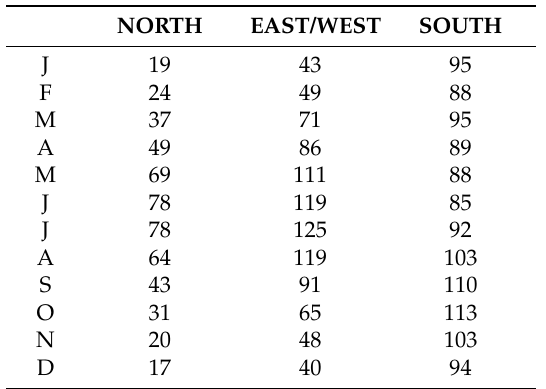
Table 2. Incident solar radiation (kWh/m 2 -mo) in Athens, on vertical surfaces with various orientations.